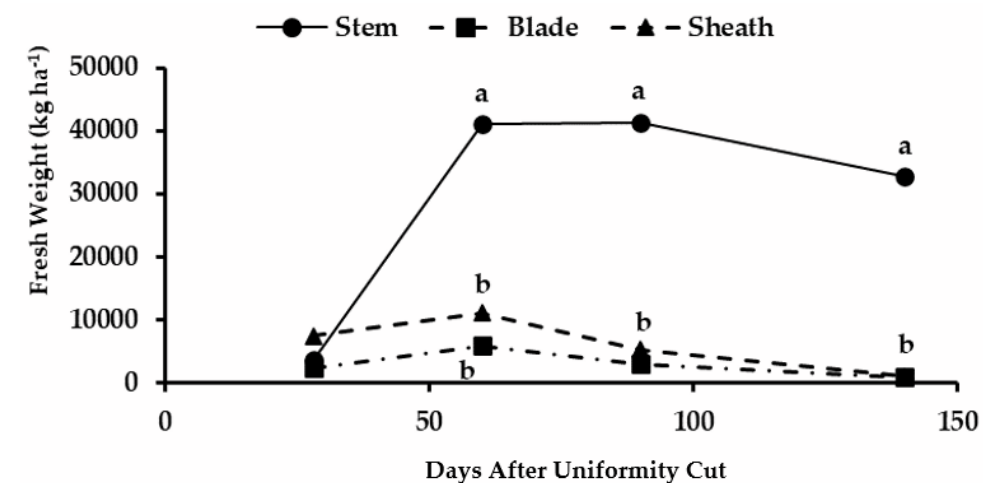
Figure 4. Fresh biomass accumulation at different organs of the basal stratum of maralfalfa plants harvested at different cutting dates. The weight values with equal letters in each stratum of the plant were statistically similar ( p ≤ 0.05).